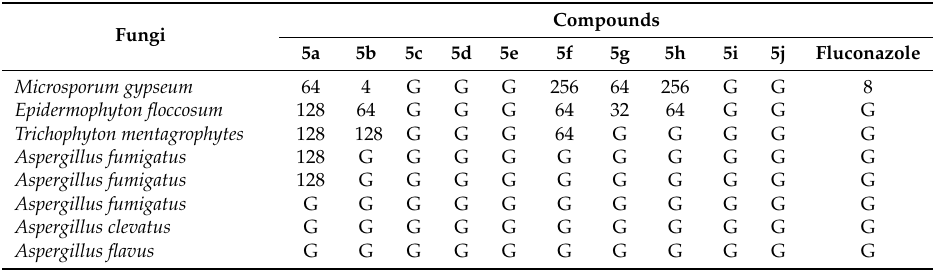
Table 2. Antifungal activities of 5a – 5j against filamentous fungi (MIC, µ g/mL).